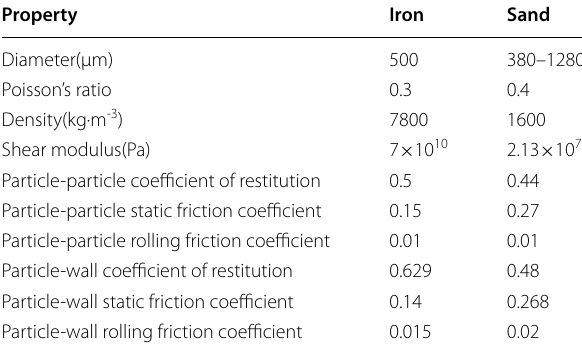
Table 1 EDEM particle simulation parameters